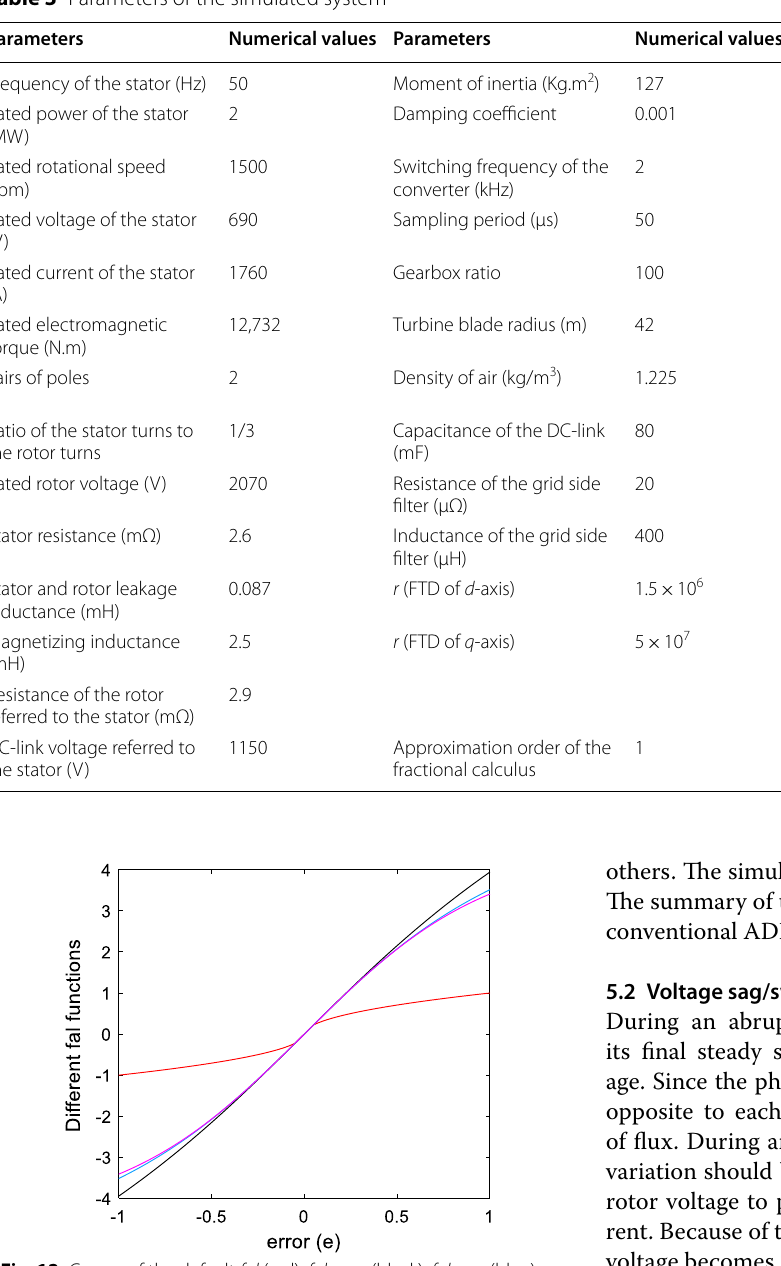
Fig. 12 Curves of the default fal (red), fal arcsinh (black), fal arctan (blue), and